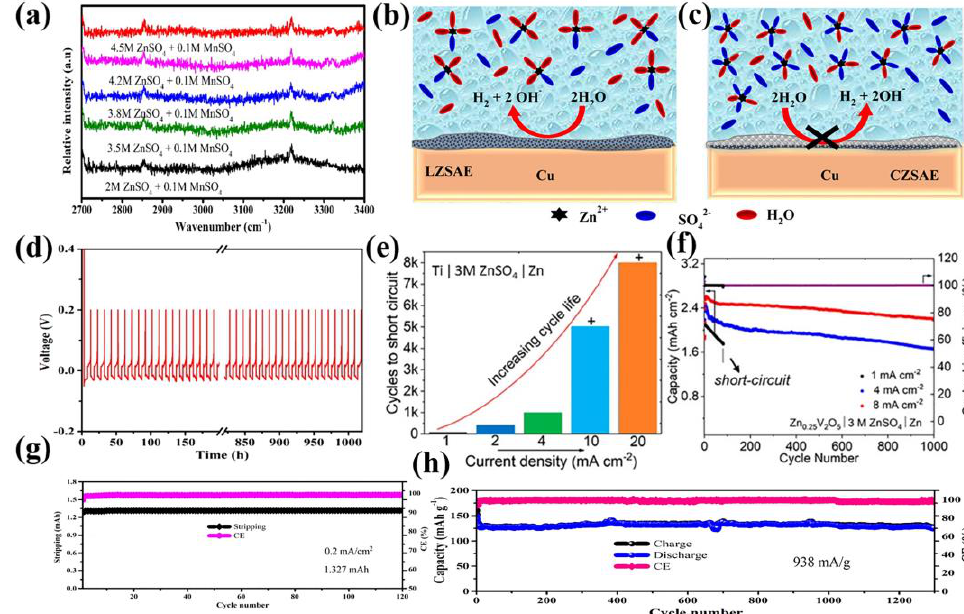
Figure 3. ( a ) Raman spectra for different concentrations of zinc-salt electrolytes. Solution